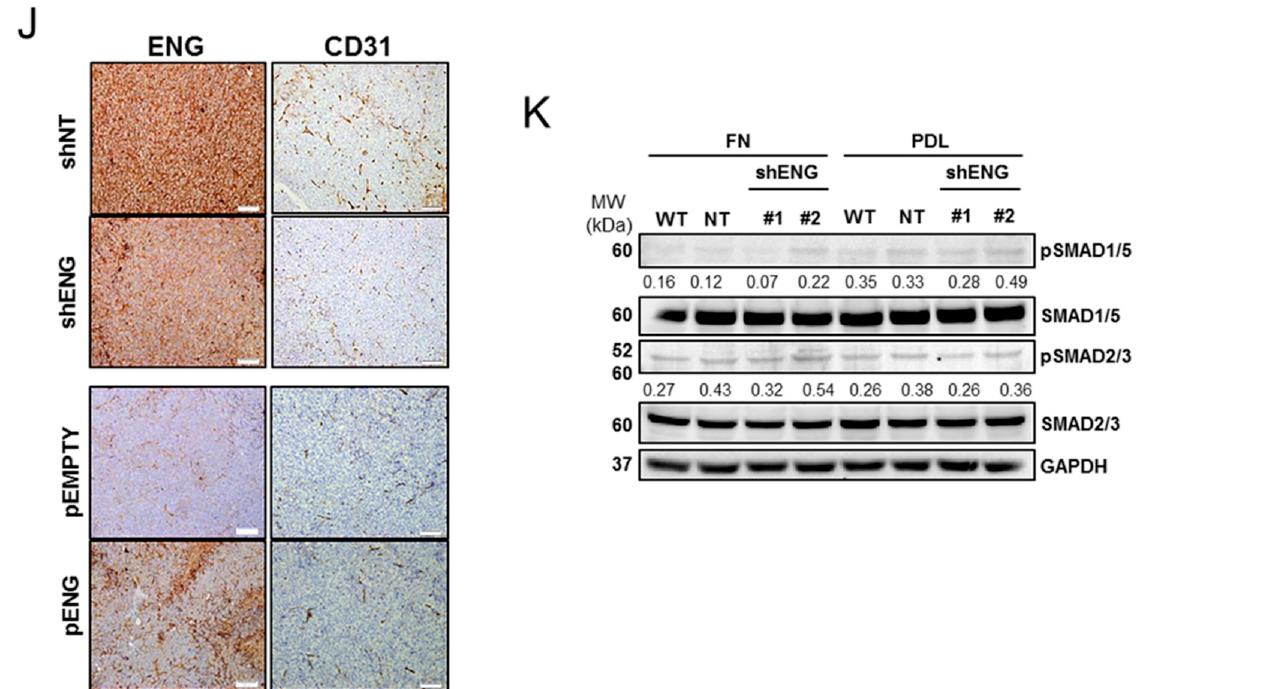
Figure 2. ENG downregulation in ES cells impairs clonogenicity, without affecting cell proliferation, independently of SMAD phosphorylation. ( A – C ) The clonogenic capacity was impaired when ENG was downregulated in both RM82 ( A ) and SK-N-MC ( B ) cells, while there was no improved clono- genic potential in the upregulated model ( C ). ( D ) In vitro proliferation was not affected by the downregulation of ENG in the RM82 model. ( E ) In vivo, the downregulation of ENG slightly im- paired the ES tumor growth, reaching significance at the endpoint. ( F ) Expression of the vessel